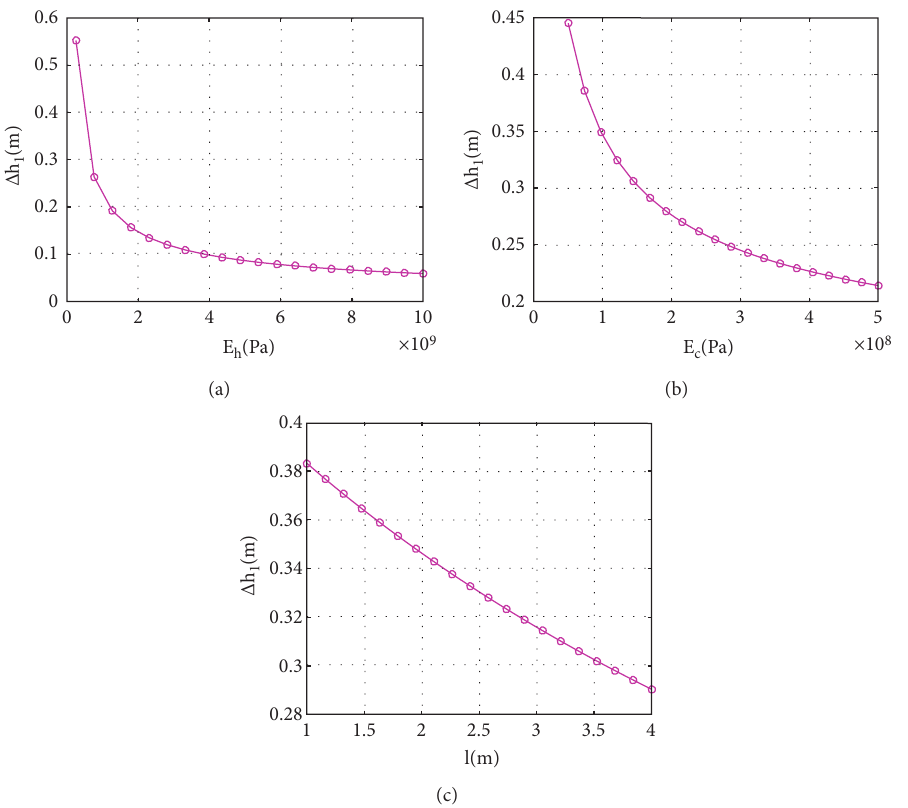
Figure 3: Effect of human-controllable factors on roof subsidence of gob-side entry. (a) EPCARM. (b) Filling body in the gob. (c) Width of